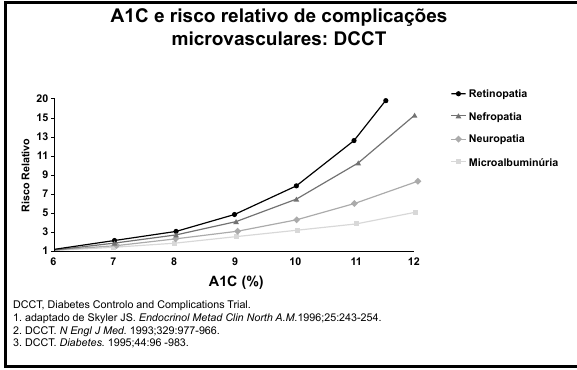
Figura 4 – Hemoglobina glicada e risco relativo de complicações microvasculares: DCCT(3)